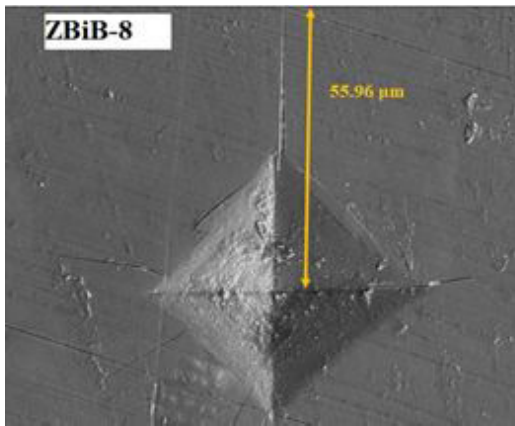
Figure 4. Graphs showing the dependence of experimental MAC values with Bi